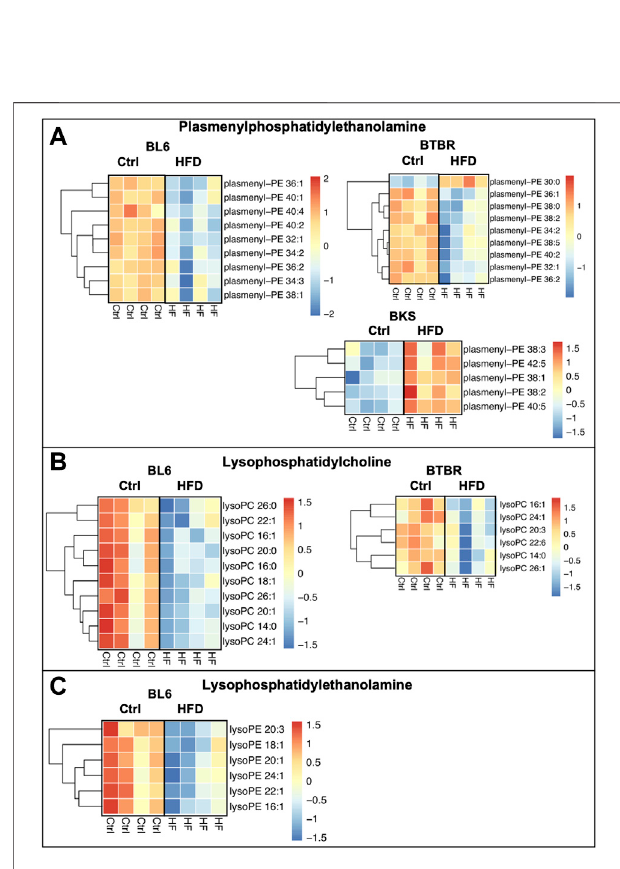
Frontiers in Physiology |